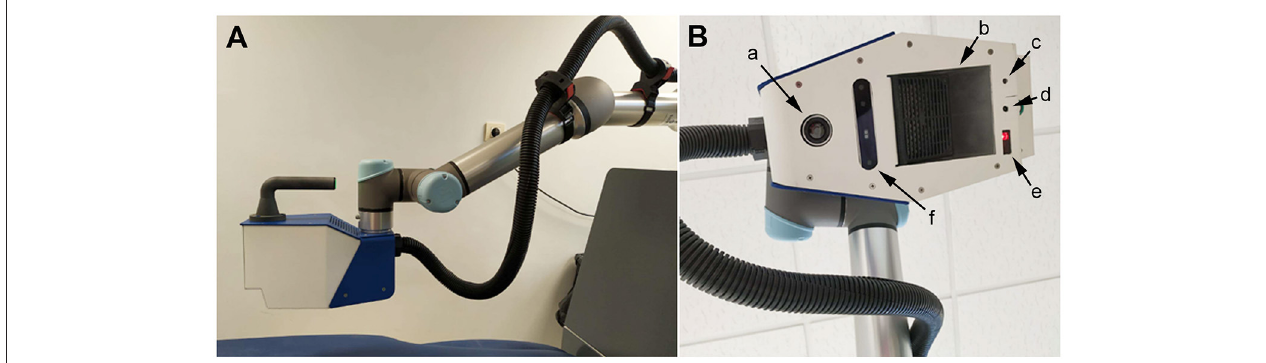
FIGURE 1 | Representative photographs of the ADAMO device showing the robotic arm with the terminal handpiece (A) , and detail of the handpiece (B) indicating the location of the thermal camera (a) , the air heater (b) , the cross selection laser (c) , the air nozzle (d) , the distance sensor (e) , and the 3D camera (f) . The black tube carries compressed air.